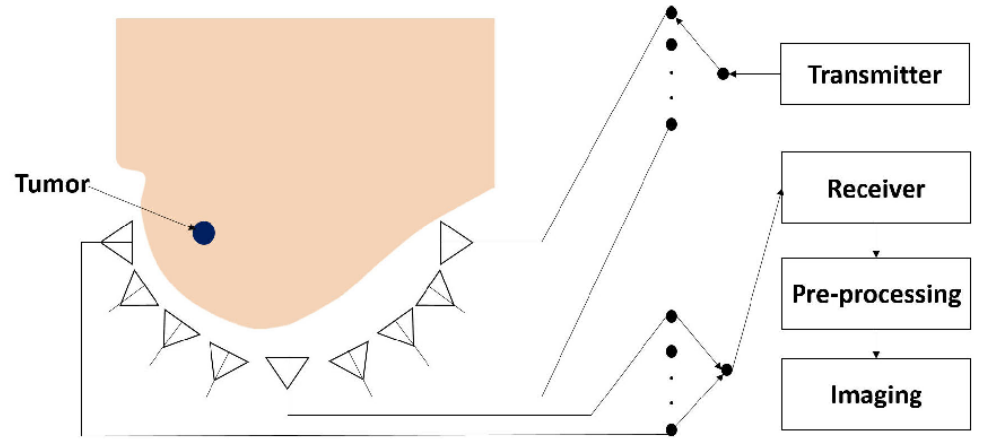
Figure 1. A typical near-field microwave imaging system for breast cancer detection [5]